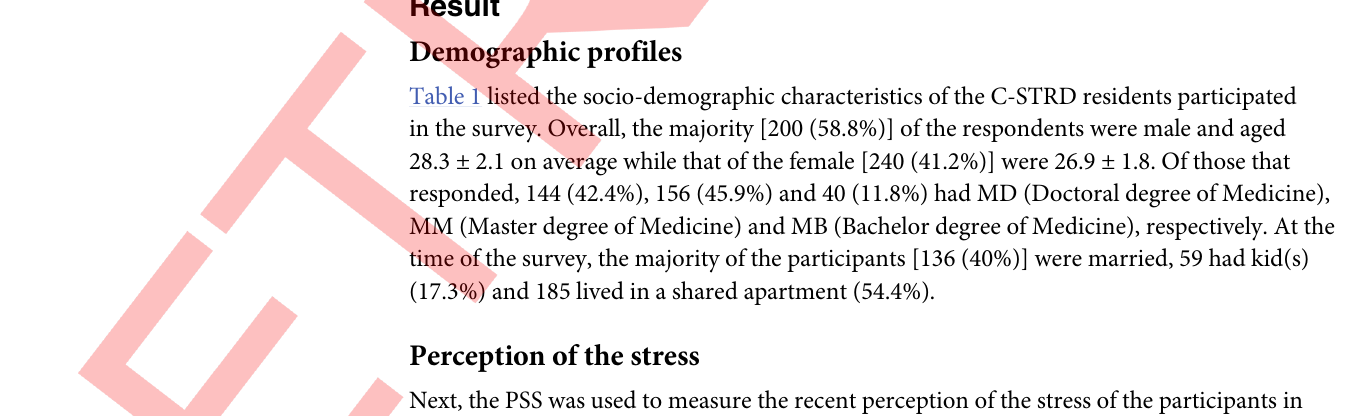
Table 1 listed the socio-demographic characteristics of the C-STRD residents participated in the survey. Overall, the majority [200 (58.8%)] of the respondents were male and aged 28.3 ± 2.1 on average while that of the female [240 (41.2%)] were 26.9 ± 1.8. Of those that responded, 144 (42.4%), 156 (45.9%) and 40 (11.8%) had MD (Doctoral degree of Medicine), MM (Master degree of Medicine) and MB (Bachelor degree of Medicine), respectively. At the time of the survey, the majority of the participants [136 (40%)] were married, 59 had kid(s) (17.3%) and 185 lived in a shared apartment (54.4%).